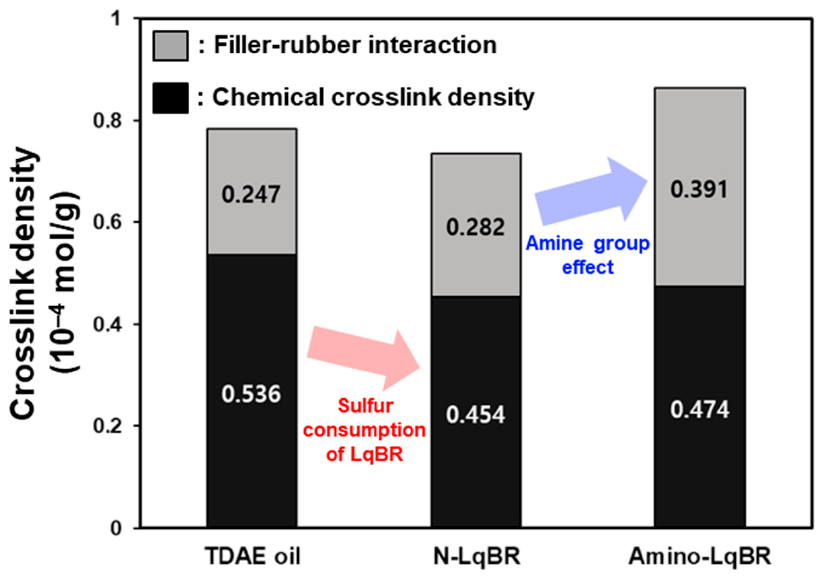
Figure 8. Crosslink density of the vulcanizates.